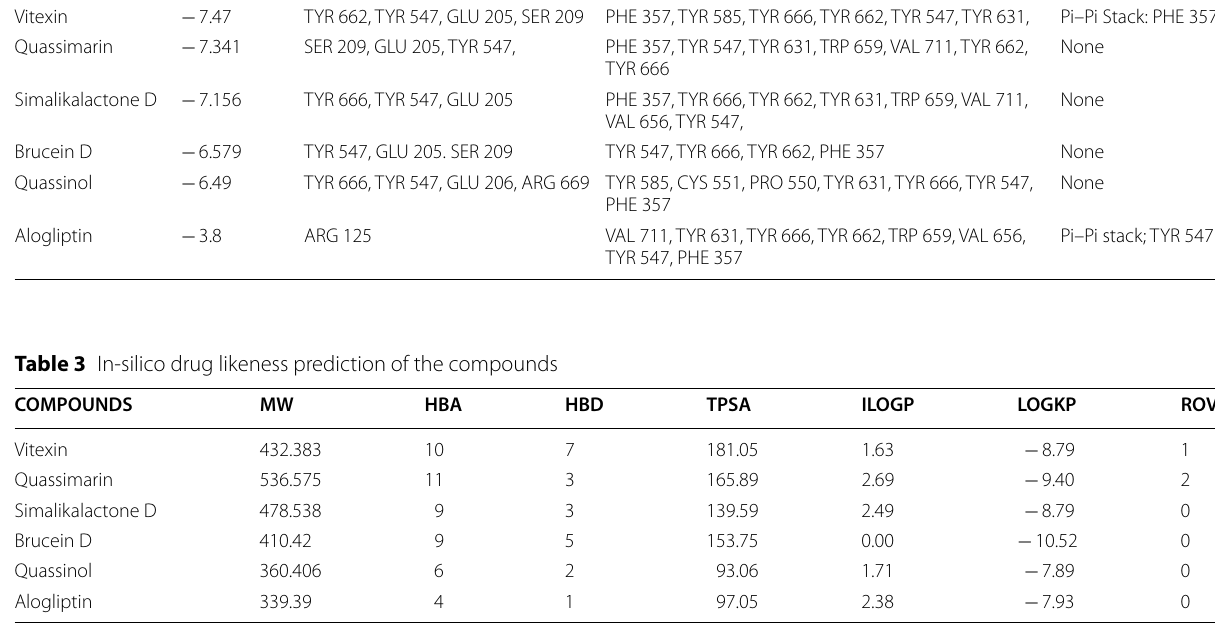
Table 2 Hydrogen Bonds and Hydrophobic interactions of the hit phytochemicals of Q. amara phytochemicals Compound name Docking score (Kcal/